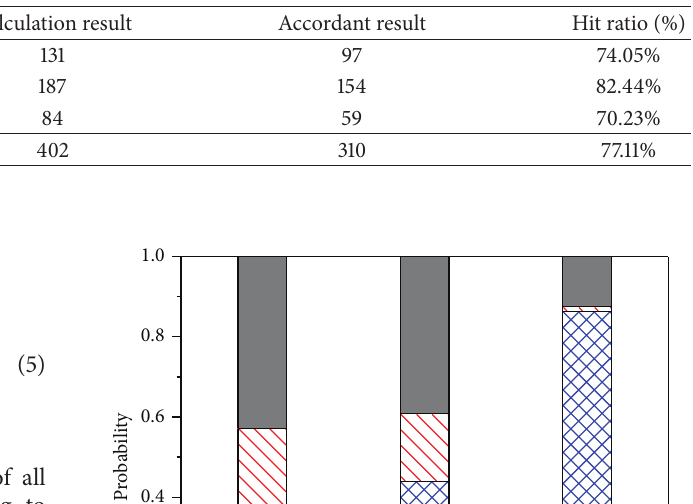
Table 4: Hit ratio of MNL model.